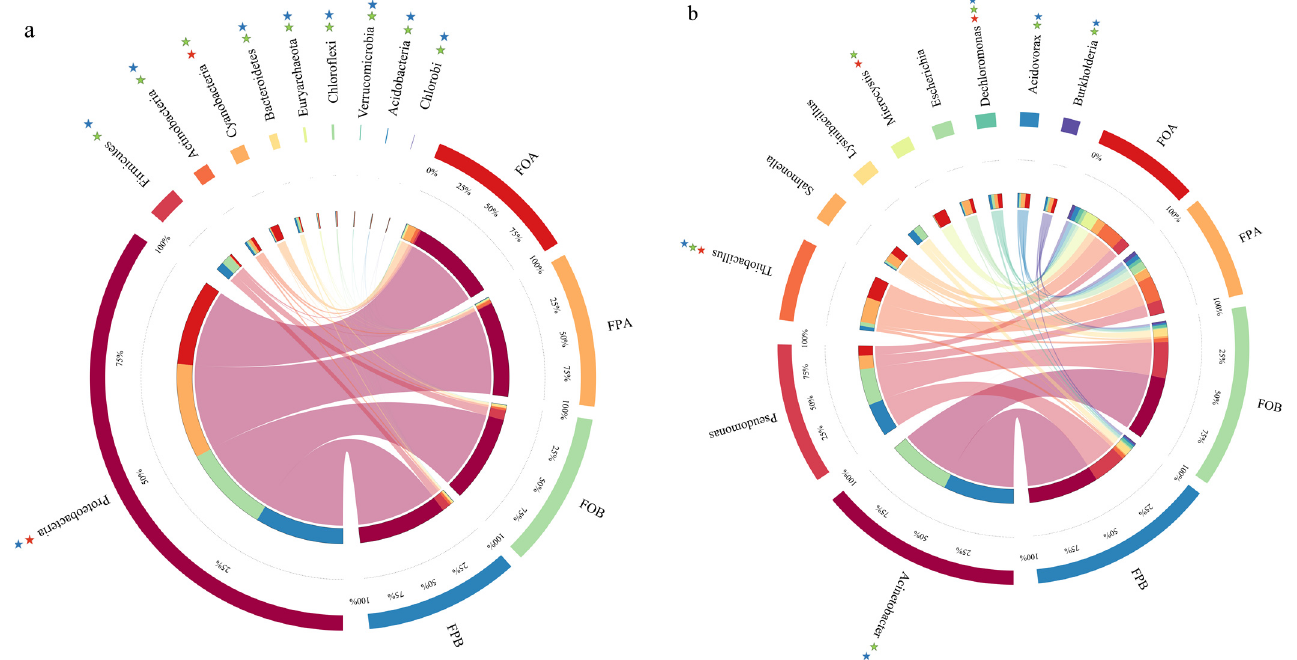
Figure 2. Relative abundances of dominant microorganism phyla ( a ) and genera ( b ) in sediment. FPB: Sediment samples in fishponds with planted lotus roots collected before cultivation; FOB: Sediment samples in ponds with only fish farming collected before cultivation; FPA: Sediment samples in fishponds with planted lotus roots collected after cultivation; FOA: Sediment samples in ponds with only fish farming collected after cultivation. Red, Green, and Blue stars indicate that the differences between FOA and FPA, FOA and FOB, FPA and FPB are significant, respectively; p < 0.05, n = 4. At the genus level, the dominant genera in FB were Acinetobacter and Pseudomonas (32.82~36.53%, 17.25~18.79%). Their abundance was significantly decreased ( p < 0.05) after